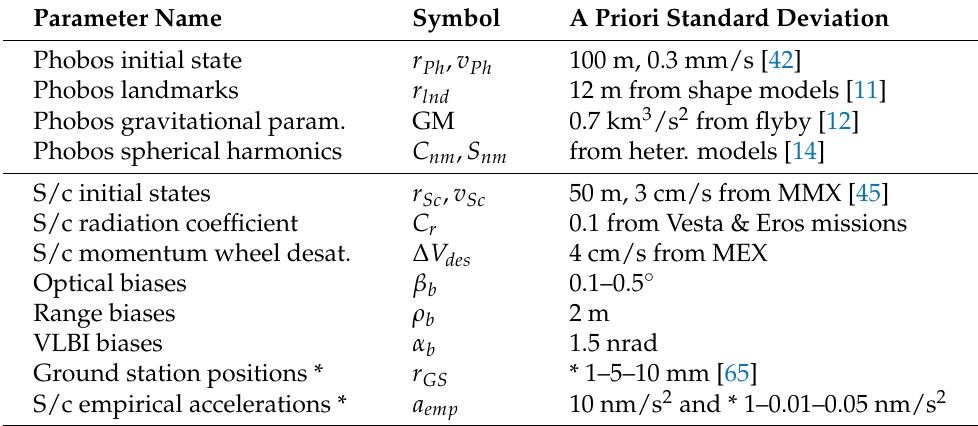
Table 4. Estimated science (top) and mission (bottom) parameters. Note that a emp is first appended as a consider parameter (which are marked with an asterisk), then estimated as a regular